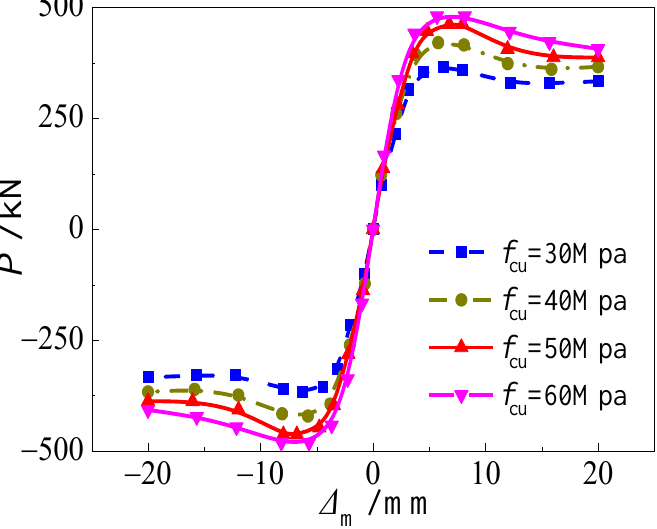
Figure 16. Effect of compressive strength of core concrete on skeleton curve.